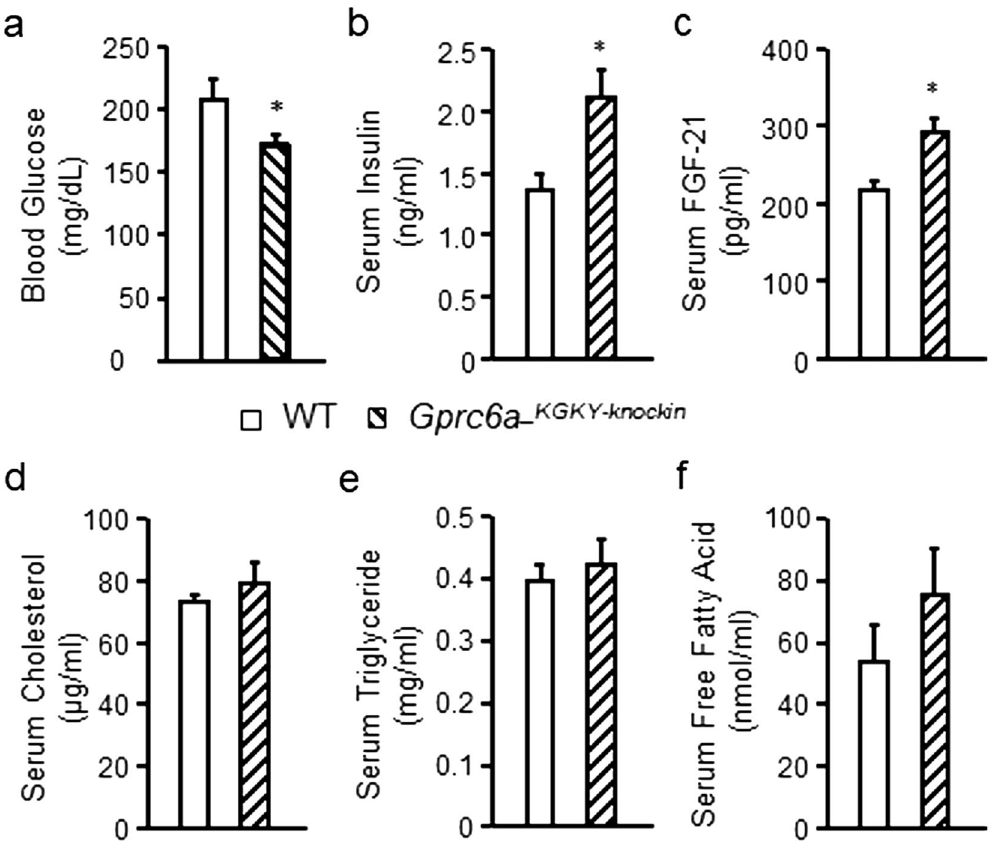
Figure 2. Characterization of Gprc6a- KGKY-knockin mice. Comparison of the fasting blood glucose ( a ), serum insulin ( b ) and serum FGF-21 levels ( c ), serum levels of cholesterol ( d ), triglyceride ( e ) and free fatty acid ( f ) in wild type and Gprc6a- KGKY-knokin male mice at age of 10 week-old. Values represent the mean ± SEM. *Significant difference between wild type and Gprc6a- KGKY-knockin mice ( P < 0.05, Student’s t test; n =